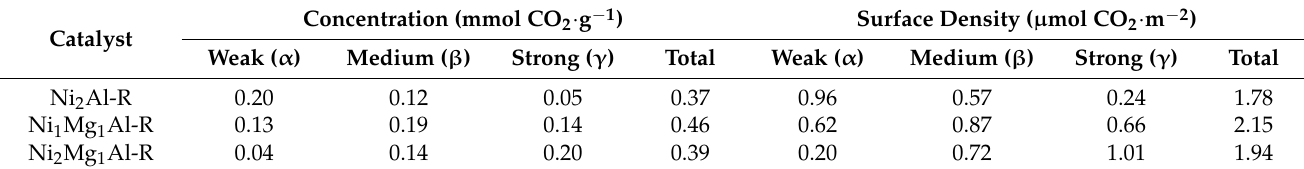
Figure 7. Basic groups on the reduced catalysts by CO 2 -TPD. Black line: recorded signal. Red line: deconvoluted signal. Blue peaks = weak ( α ); green peaks = intermediate ( β ); red peaks = strong sites ( γ ). Table 6. Concentration and surface density of weak ( α , T d < 200 ◦ C), intermediate ( β , 200 ◦ C < T d < 500 ◦ C), and strong ( γ , T d > 500 ◦ C) basic sites determined by CO 2 -TPD.